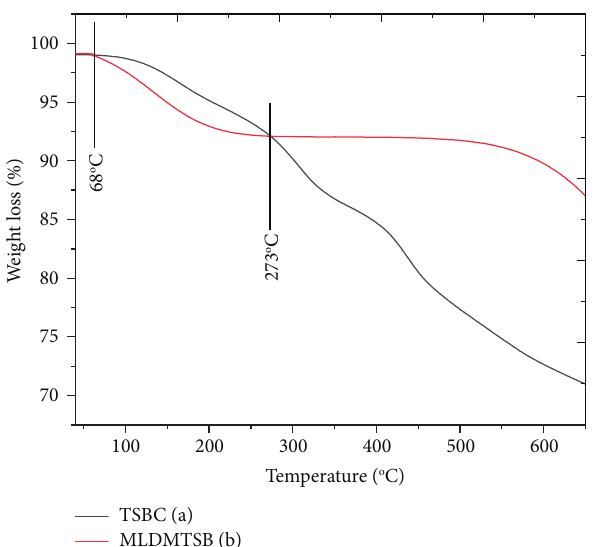
Figure 4: Thermogravimetric analysis of Teff straw biochar and lanthanum doped magnetic Teff straw